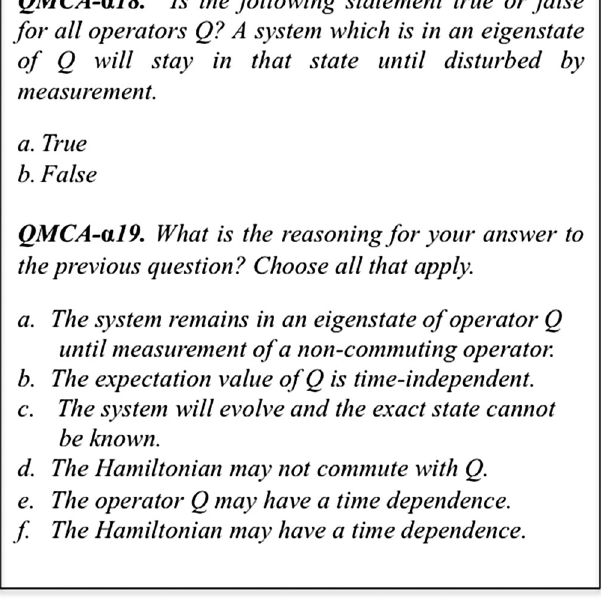
FIG. 5. The alpha version of two MC questions corresponding to open-ended QMAT